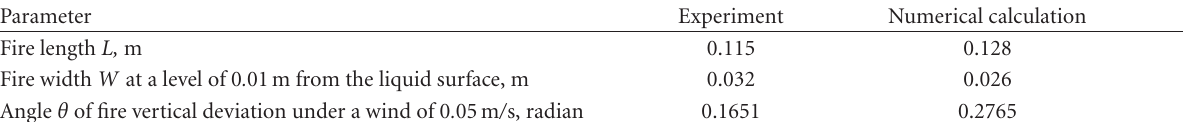
Table 1: Comparison of full-scale measurements and results of numerical simulation of an isooctane fire.